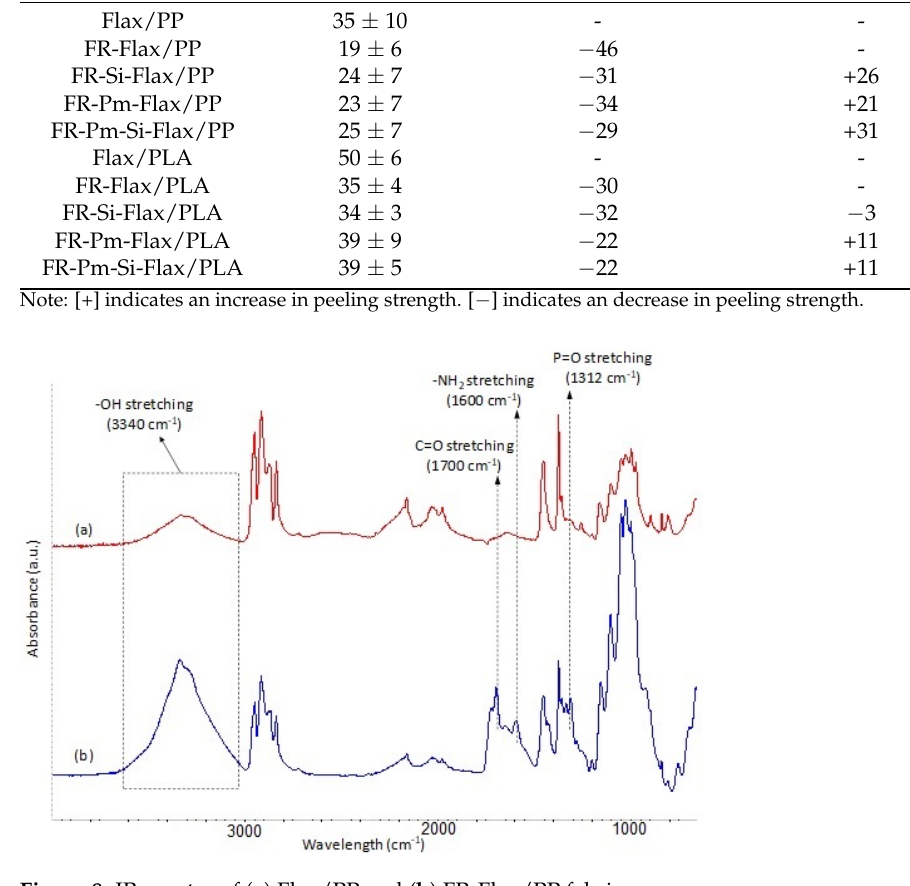
Figure 8. IR spectra of ( a ) Flax/PP and ( b ) FR-Flax/PP fabrics.